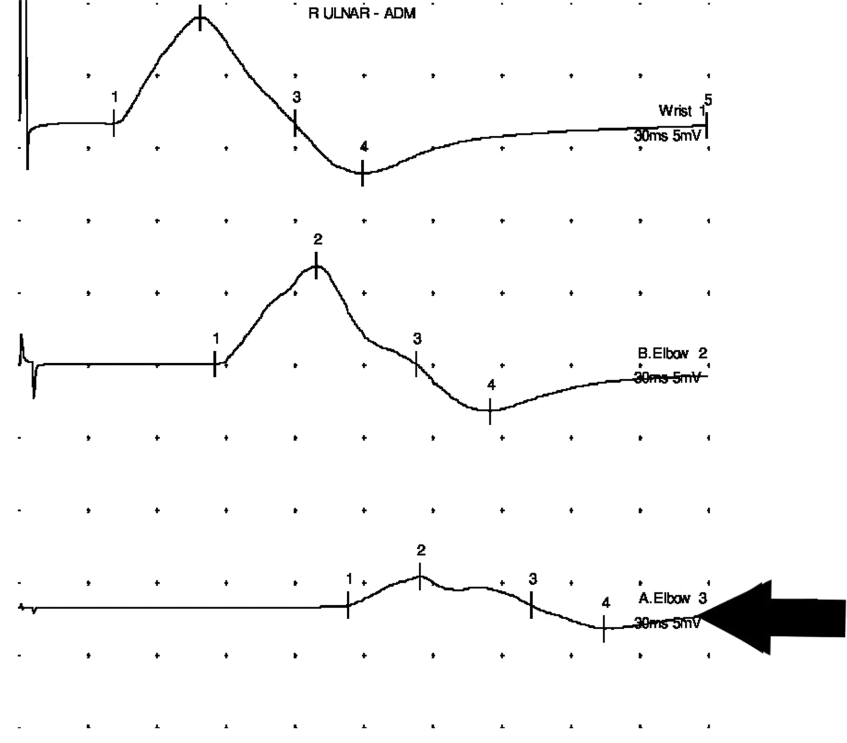
Content of this journal is licensed under a Creative Commons Attribution 4.0 International